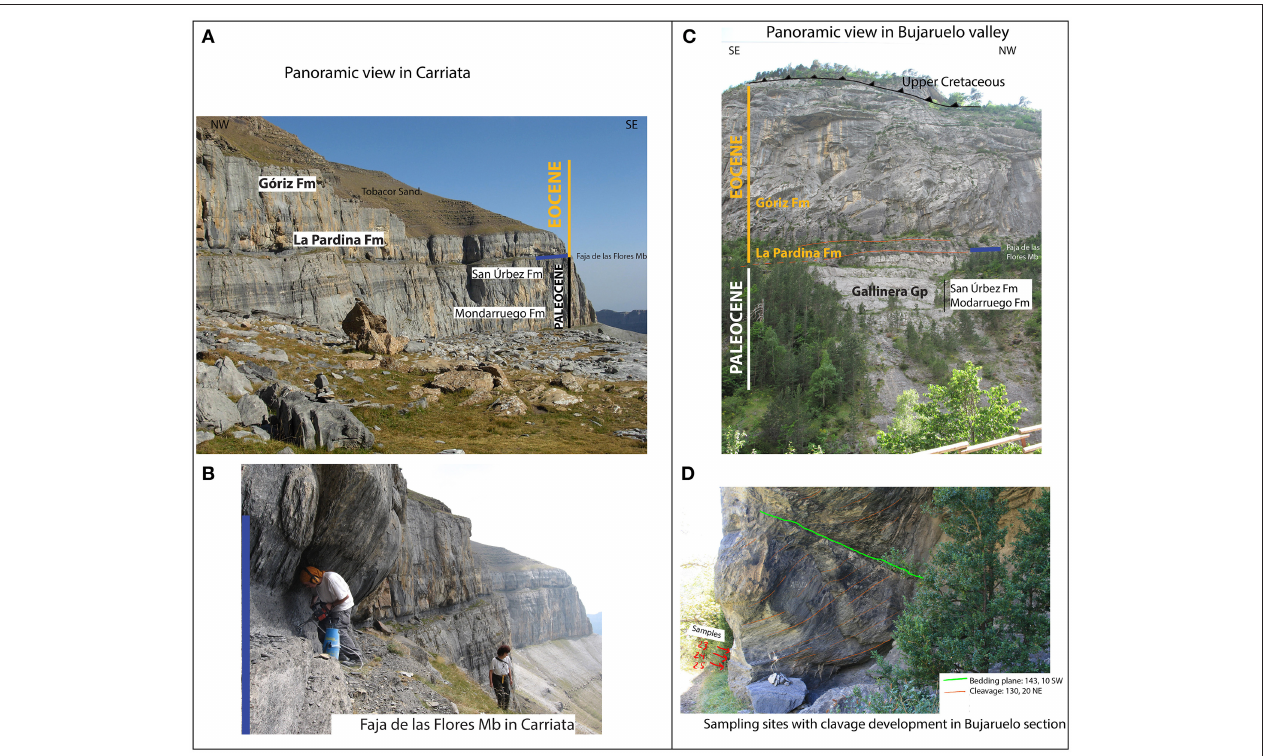
FIGURE 2 | Pictures showing the Gallinera Gp, the PETM of La Pardina Fm, and the Faja de las Flores Mb, (A) Panoramic view of Carriata section, (B) detail of Faja de las Flores Mb, (C) panoramic view of Bujaruelo section, and (D) details of sampling site with cleavage and bedding planes.